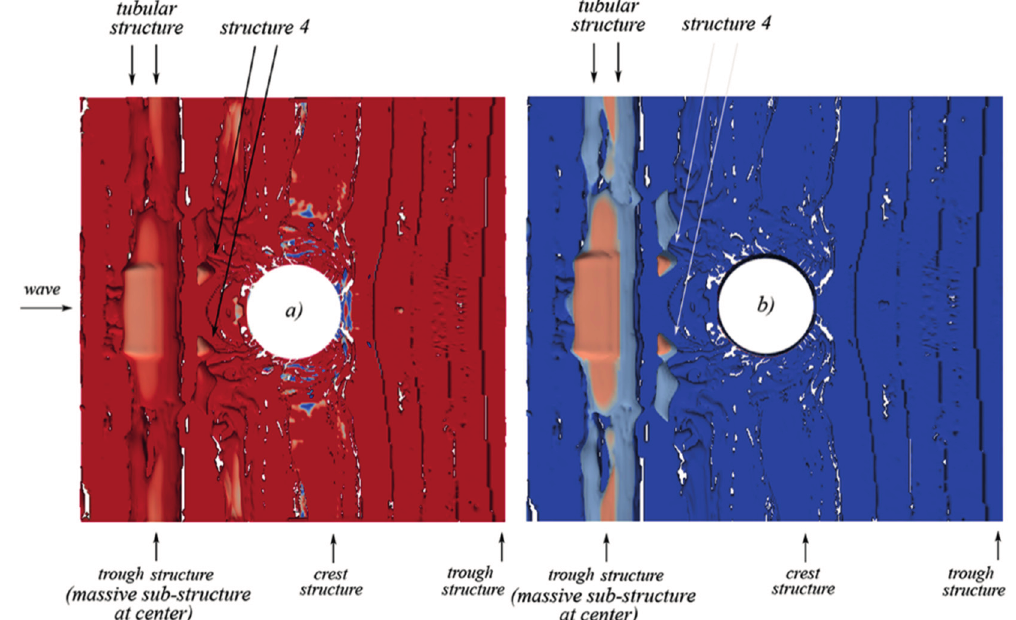
Figure 23. Close-up views of structures as obtained from the solution of the Navier-Stokes equations. Bottom view of computing domain at structures are colored with: ( a ) wave-field spanwise vorticity; ( b ) wave-field pressure